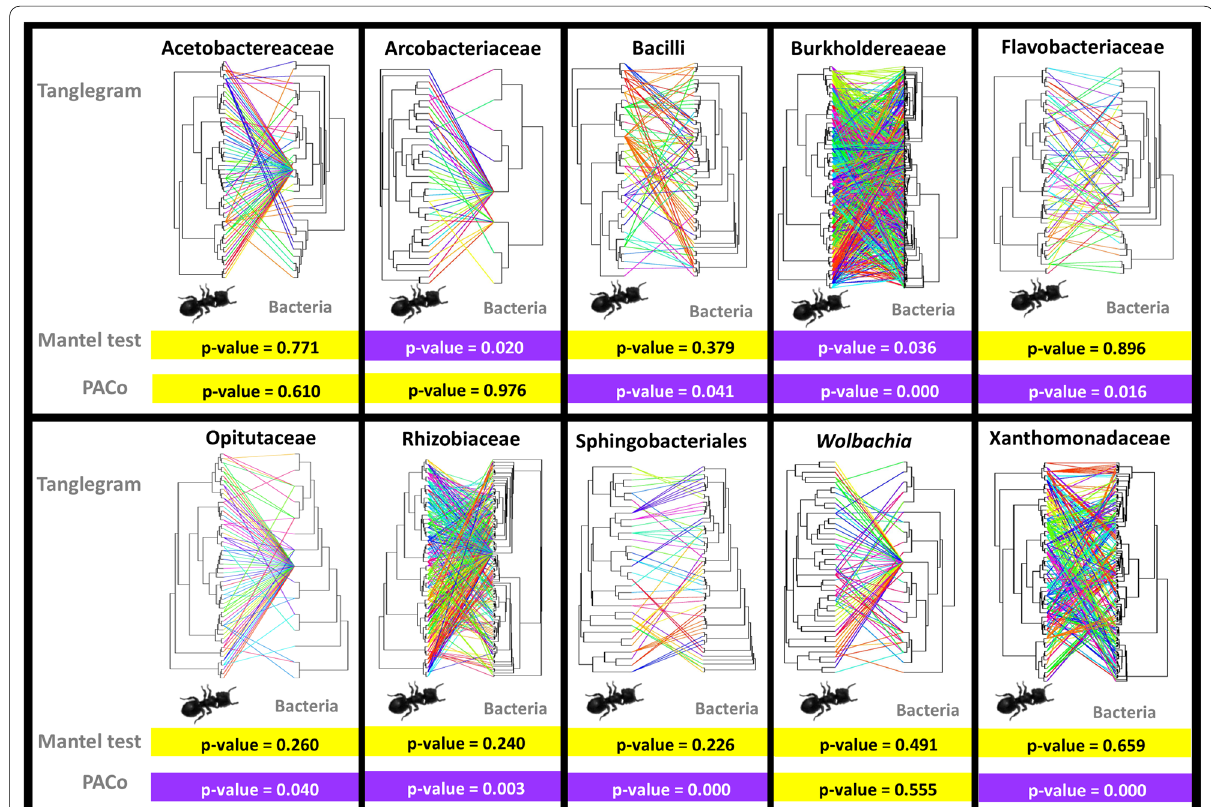
Fig. 6 Exploring the coevolution signal of each core bacterial lineage associated with Cephalotes. Note that in addition to visualizing the bacteria occurrence in the host through a tanglegram, two statistical tests are applied to explore the coevolutionary signal of the bacterial communities and turtle ant evolutionary history: Mantel test and PACo analysis. P value less than 0.05 suggesting codiversification are highlighted in purple, and greater than 0.05 highlighted in